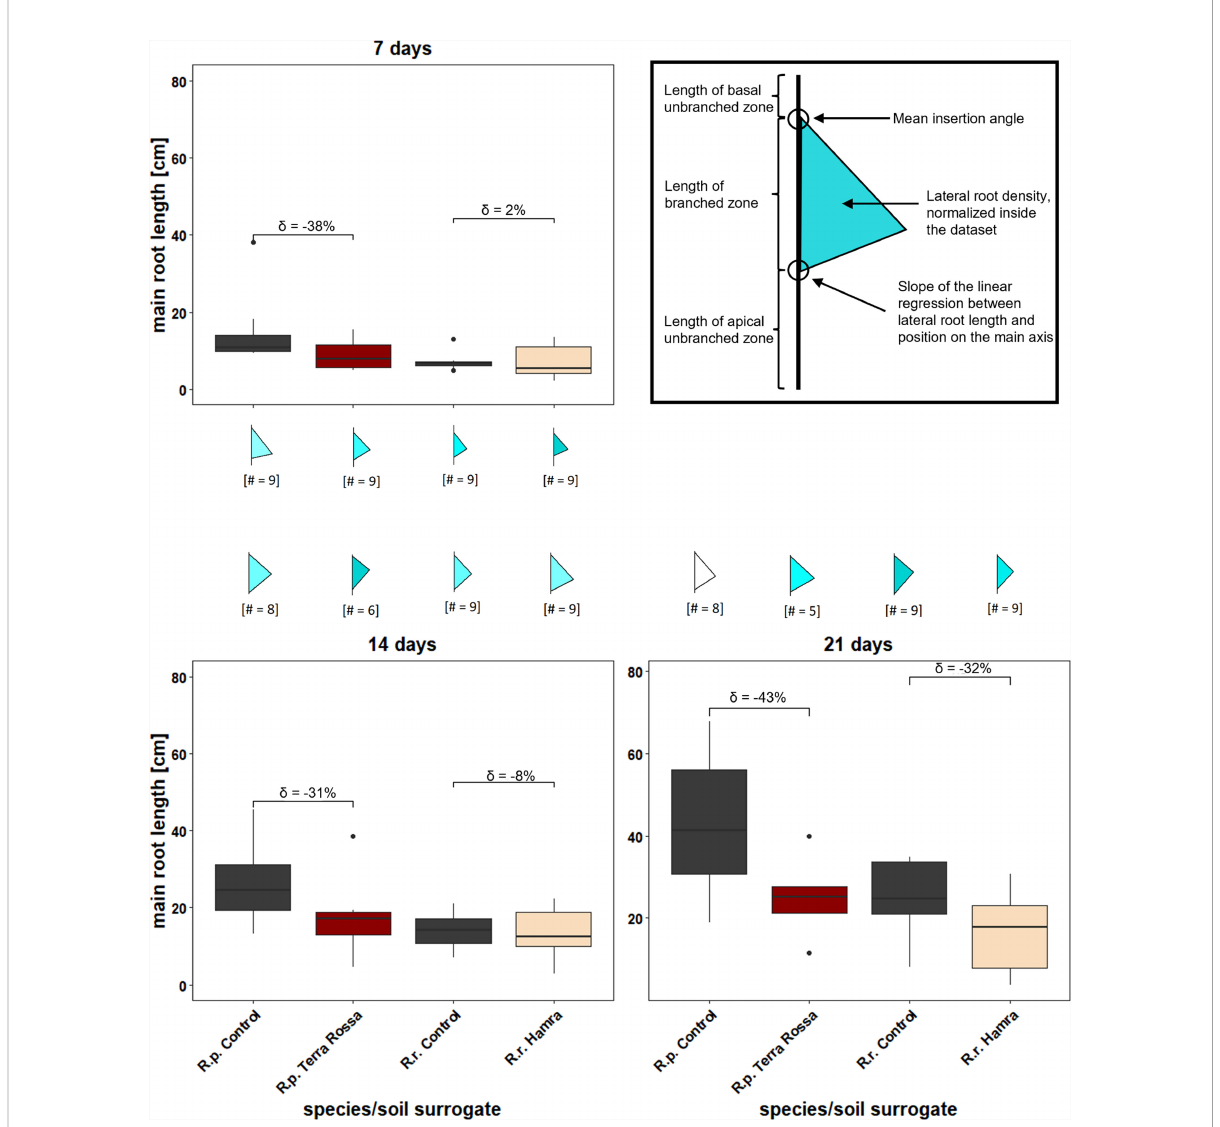
FIGURE 6 Different root growth kinetics in diverse surrogates of soil types indicates a faster root growth on control, than on the species natural soils. Native soil types of both species, R. pugioniformis Rp , Terra Rossa) and R. raphanistrum ( Rr , Hamra), along with a control, were mimicked by speci fi c nutrient solutions (details see M&M). Root growth was recorded after one, two, and three weeks for semi-automated root architecture analyses. The percentage difference of main root length between control and native soil of the respective species are represented as delta ( d ) above the box plots. The corresponding fl ag plots represent summary of different root system architecture parameters computed via EZ-Rhizo II. A typical " fl ag plot" (upper right panel with bold outline) represents mean insertion angle of lateral roots, displayed by the upper angle from " fl agpole" and " fl ag", length of different root zones, departed by the triangle into basal unbranched zone, length of branched zone and length of apical unbranched zone. Furthermore, lateral root density is indicated by the color intensity within the triangle, ranging from white (low) to dark turquoise (high root density) and the slope of the linear regression, displayed by the lower angle (details see M&M). Rp = R. pugioniformis , Rr = R. raphanistrum